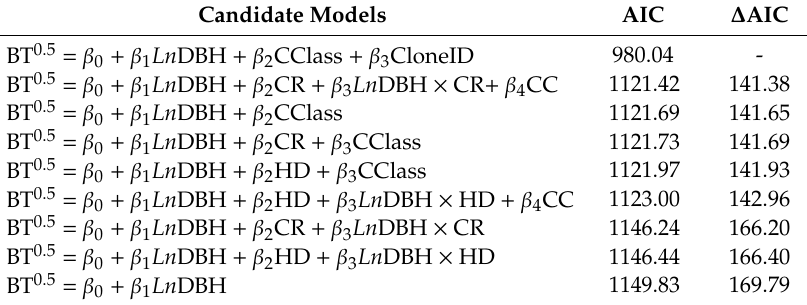
Table 4. Comparing candidate even-aged redwood bark thickness (BT) models. Generalized linear mixed-e ff ects models for square-root transformed BT (mm) as a function of candidate fixed e ff ects: DBH, height:diameter ratio (HD), crown ratio (CR), crown class (CC), and a unique sprout clump identifier (CloneID) included in every model as either a fixed or a random e ff ect. Models fitted to redwood tree data ( n = 571) for three even-aged stands at age 85 years in Jackson Demonstration State